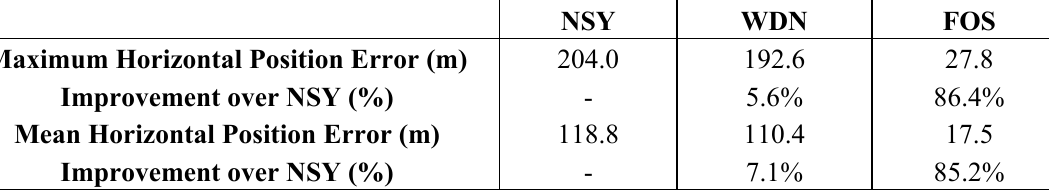
Table 3. Summary of position domain accuracy